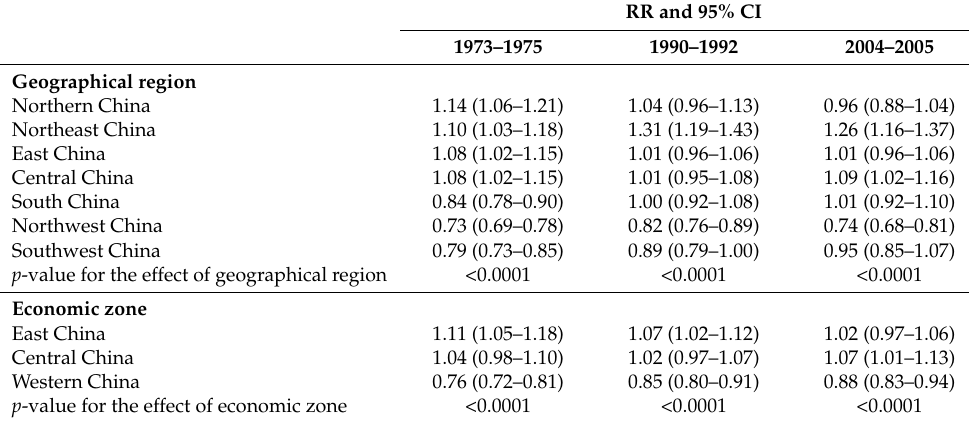
Table D1. Estimates of mortality rate ratio (RR) * and 95% confidence interval (CI) of breast cancer among Chinese women by geographical area across three time periods, 1973–1975, 1990–1992, and